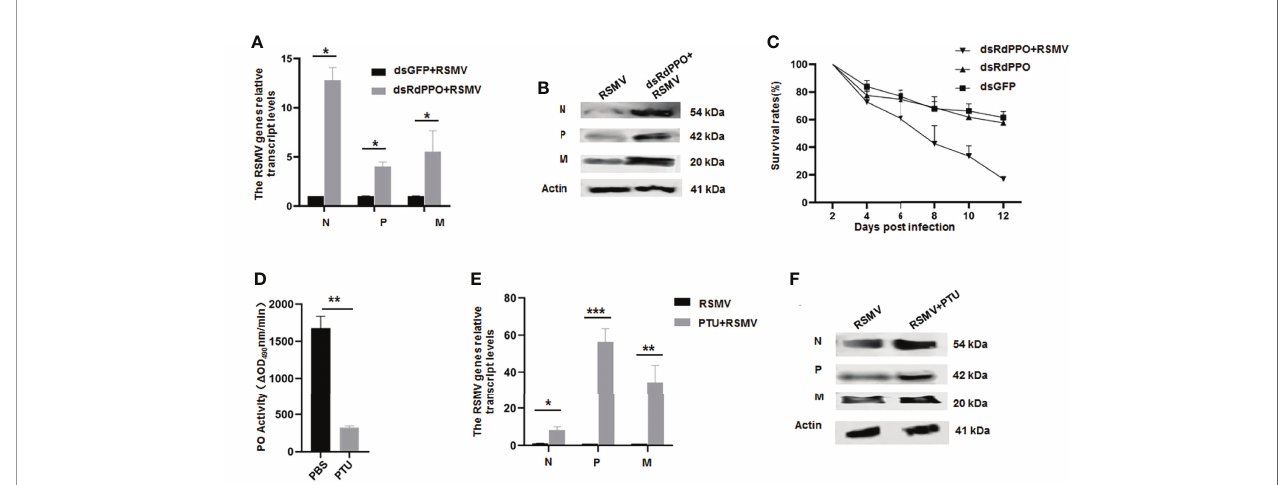
FIGURE 3 | The antiviral function of melanization during RSMV infection of R. dorsalis . (A) Transcript levels of RSMV genes in viruliferous Recilia dorsalis microinjected with dsRNAs analyzed by RT-qPCR. At 7 d post microinjection, RT-qPCR was used to detect the transcript levels of N, P, and M genes in different groups. (B) RSMV N, P, and M levels in viruliferous Recilia dorsalis at 5 d post-microinjection with dsRdPPO or dsGFP, as detected by immunoblotting with speci fi c antibodies. Insect Actin protein was used as an internal control. (C) Survival rates of dsRdPPO- or dsGFP-treated viruliferous and nonviruliferous R. dorsalis . Each point represents the mean value of triplicates, and the error bars indicate standard deviation. (D) Variations in PO activity in viruliferous R. dorsalis after injection of PBS of PTU. Hemolymph samples were collected at 5 d post-infection from at least 20 leafhoppers per group and subjected to activity assays. (E, F) Variations in N, P, and M RNA and protein levels in whole bodies of viruliferous R. dorsalis after treatment with PTU. The RNA levels of N, P, and M were quanti fi ed by RT-qPCR (E) . Speci fi c antibodies of N, P, and M were used to quantify protein levels via immunoblotting. Insect Actin protein was used as an internal control (F) . *P < 0.05; **P < 0.01; ***P <